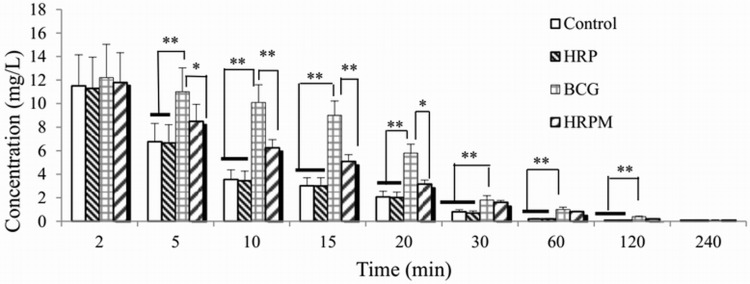
Plasma concentration-time profiles of midazolam (10 mg kg-1) following its intravenous injection in control, BCG-stimulated-, HRP-, and BCG + HRPM-treated rats.Blood samples were collected at 2, 5, 10, 15, 20, 30, 60, 120, and 240 min after midazolam administration. Plasma midazolam was measured as described in the Materials and Methods section. Data are means ± SD, n = 6, asterisks stars above bars indicate differences between groups.